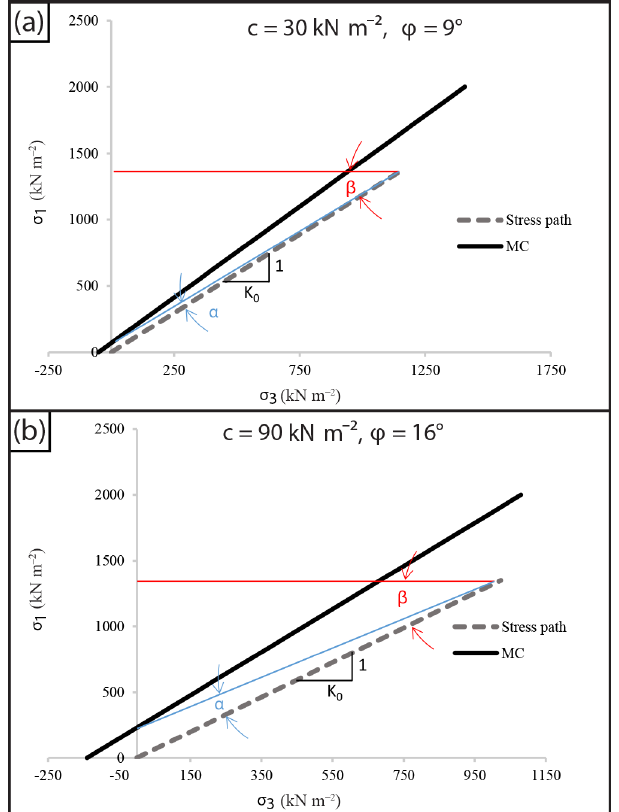
Figure 17. (a) Estimation of β and α for c = 30kNm − 2 and φ = 9 ◦ . β > 1 means positive σ 3 . (b) Estimation of β and α for α c = 90kNm − 2 and φ = 16 ◦ . β > 1 means positive σ 3 . α